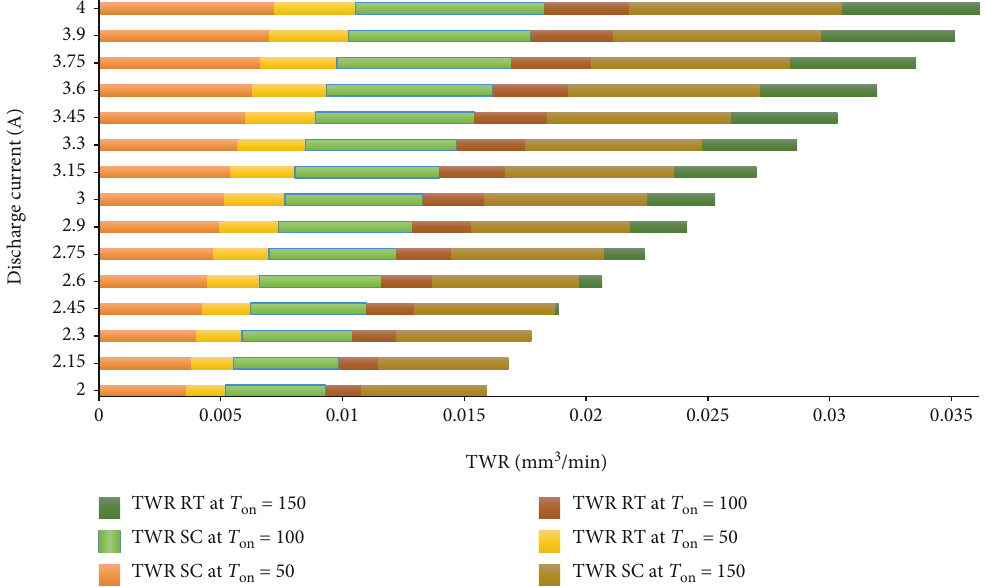
Figure 3: TWR vs. discharge current for two types of electrode at τ = 70 %